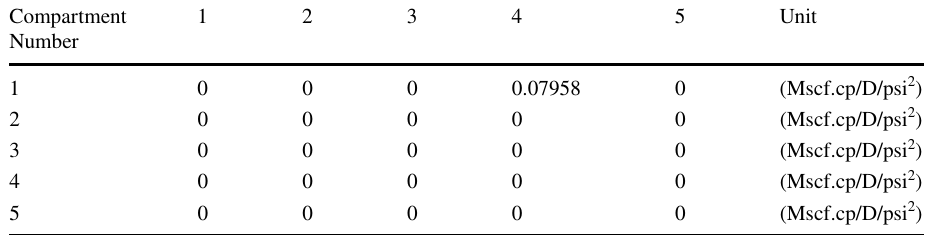
parameters for layer 3 in field case